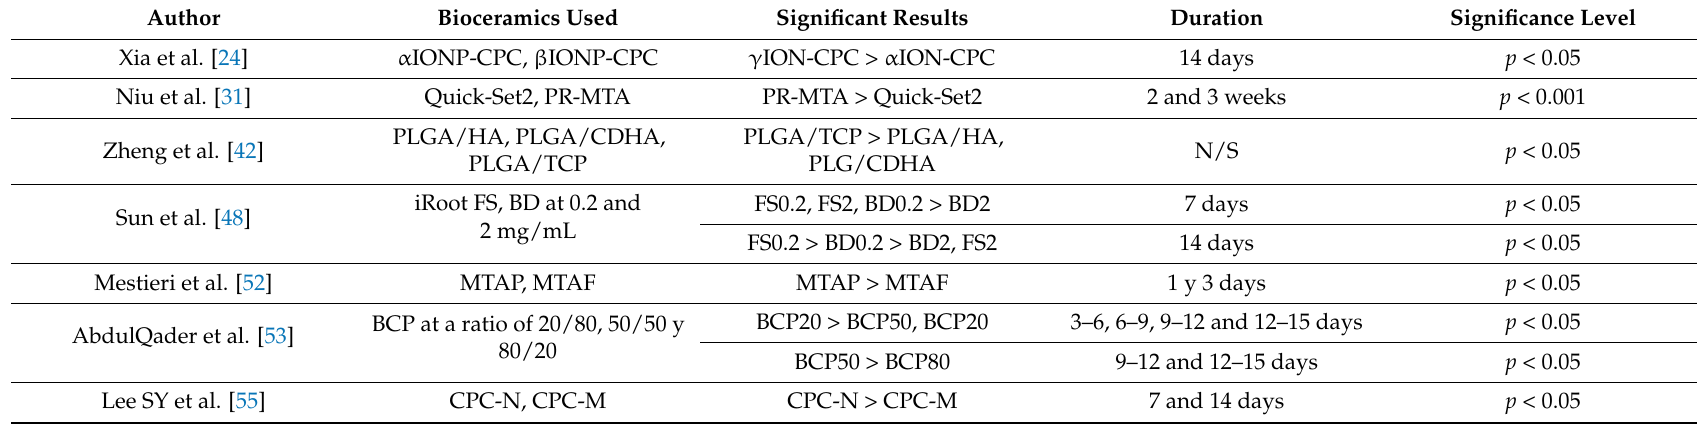
Table 14. Summary of the results of included studies showing significant differences between various bioceramic materials or different concentrations of the same bioceramic material for ALP activity.